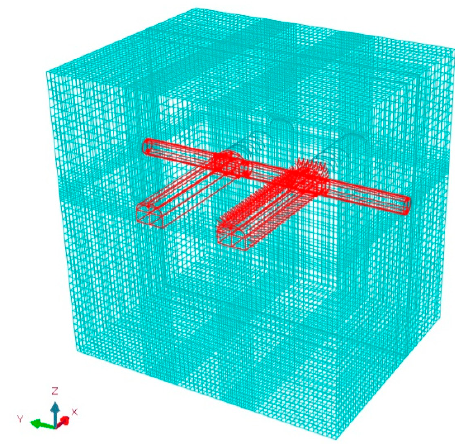
Figure 14. Grid graph of a 3D numerical model.